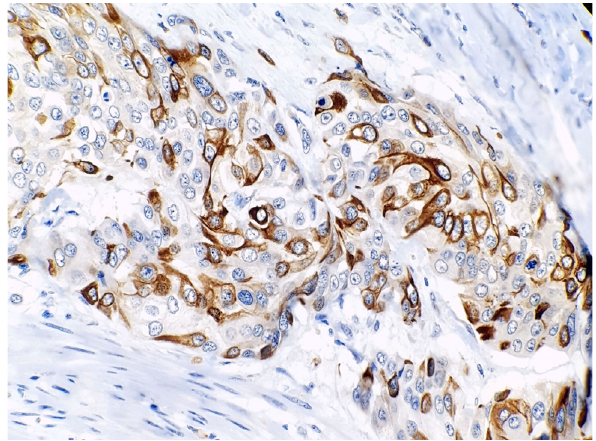
Fig. 2. Diffuse positivity of CD133 in high-grade urothelial car- cinoma (magnification x400).